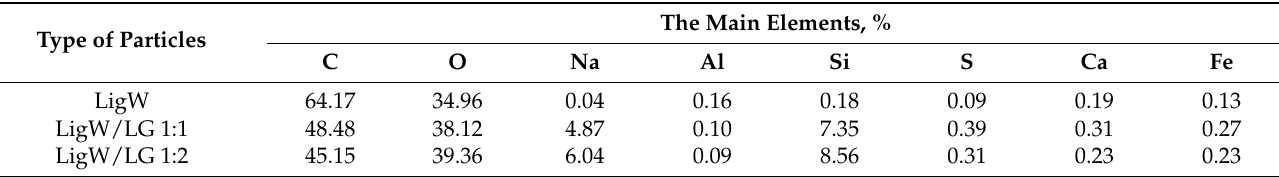
Figure 1. SEM images and particle size distribution of LigW and LigW/LG particles: ( a ) LigW particles (magnification × 100); ( b ) granulometry of LigW particles; ( c ) LigW/LG 1:1 particles (magnification × 100); ( d ) granulometry of LigW/LG 1:1 particles; ( e ) LigW/LG 1:2 particles (magnification × 100); ( f ) granulometry of LigW/LG 1:2 particles.